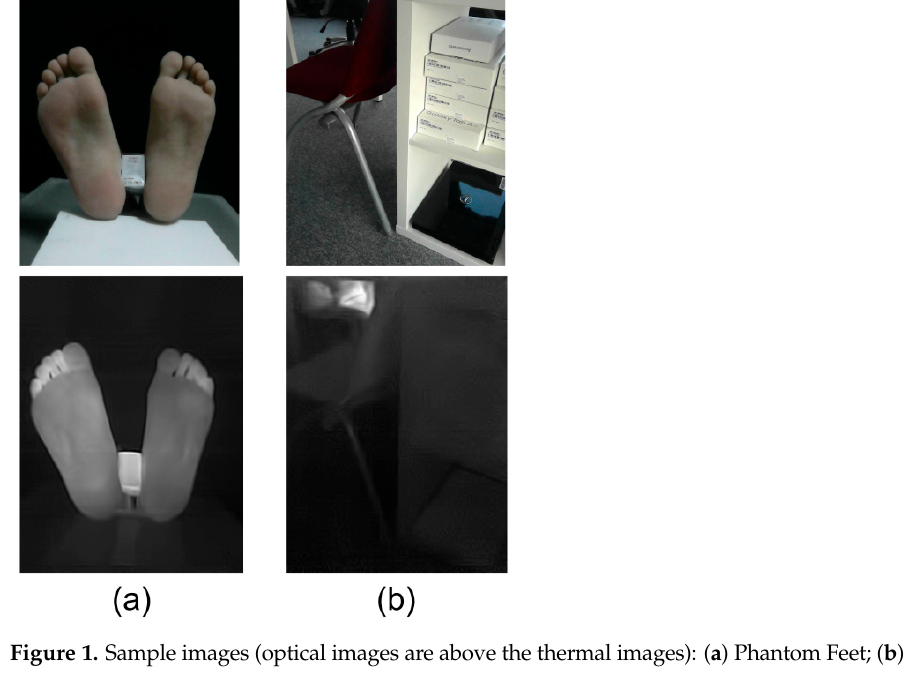
Figure 1. Sample images (optical images are above the thermal images): ( a ) Phantom Feet; ( b ) No Feet.